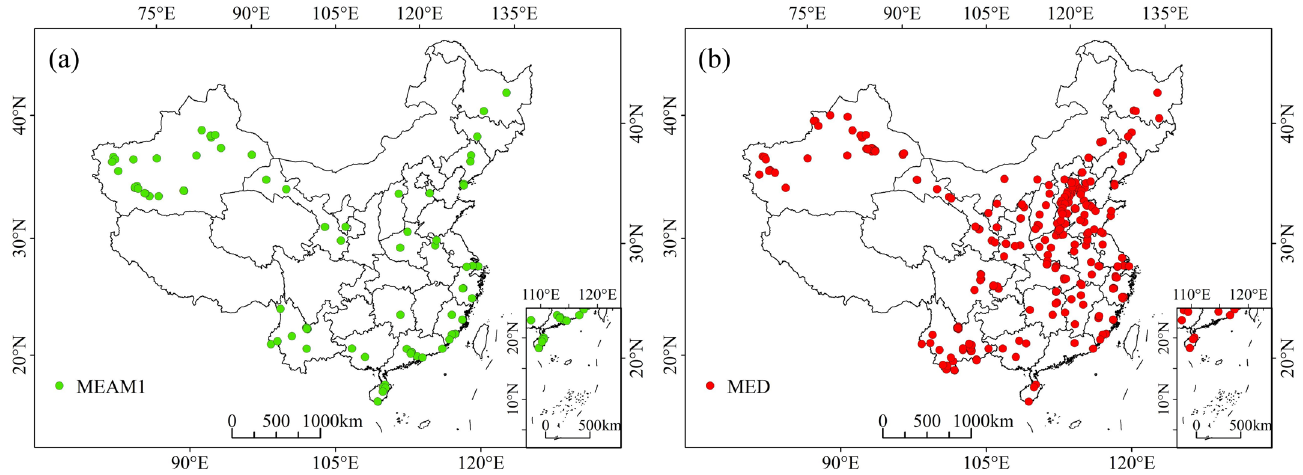
Figure 1. Distribution of the occurrence records used in the MaxEnt models of ( a ) MEAM1 and ( b ) MED cryptic species of the Bemisia tabaci species complex in China.